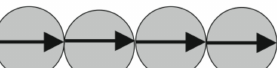
Figure 7. Illustration of a linear chain. The arrows indicate the magnetic moments of the